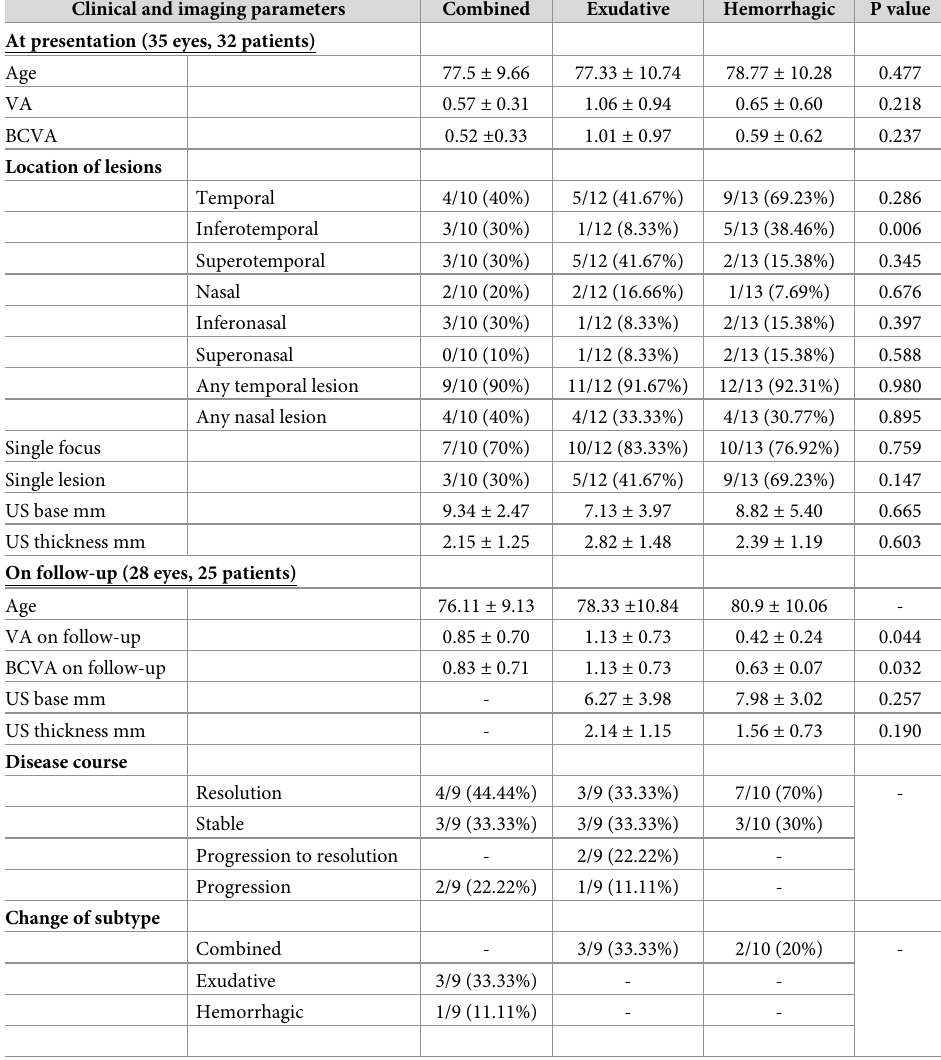
Table 3. PEHCR clinical subtypes. Clinical and imaging parameters